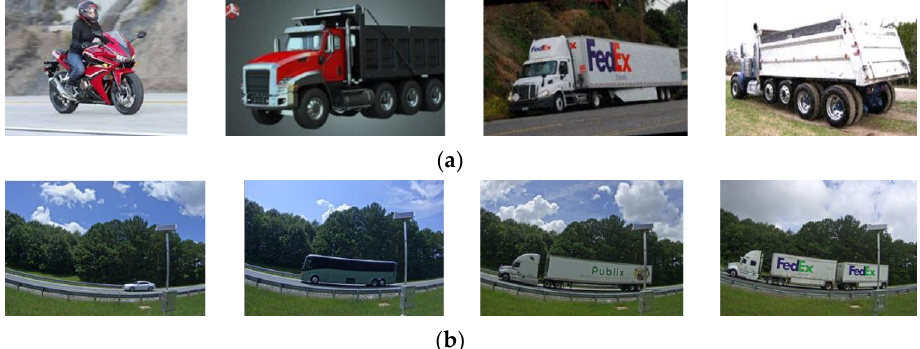
Figure 2. Examples of vehicle images in the dataset. ( a ) Vehicle images from the ImageNet. ( b ) Ve- hicle images collected at the GDOT WIM sites.